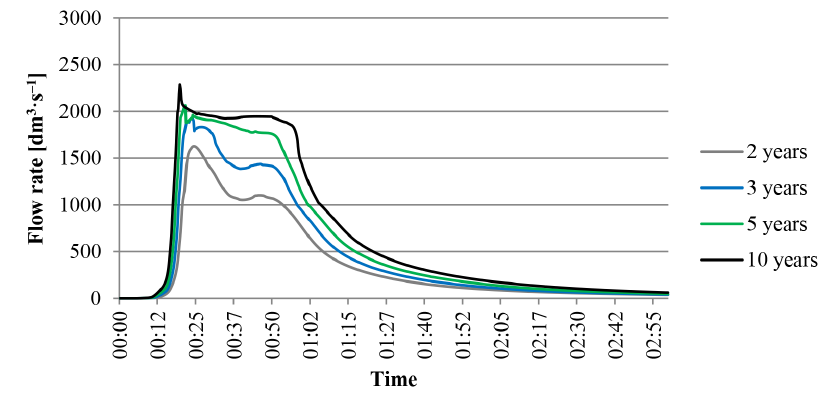
Figure 8. Changes in flow intensity through channel Link-30 – existing system prior to modernization after implementing rain barrels